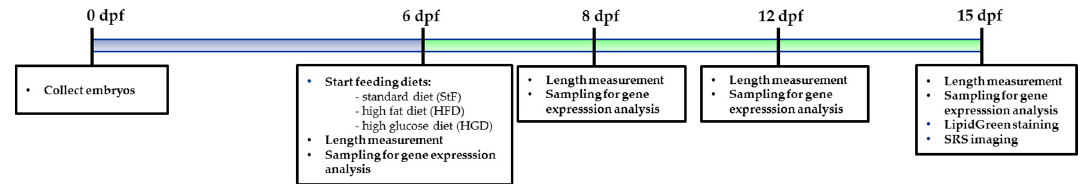
Figure 11. Schematic representation of the procedure used to analyze the effects of different diets on adipocyte development in zebrafish larvae.